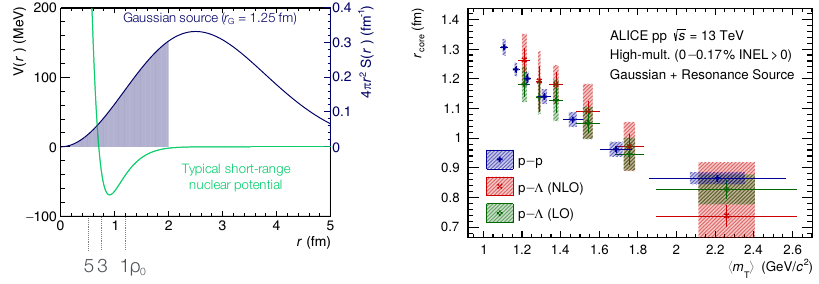
Figure 2. Left: the Gaussian source distribution (blue) for a source size of r G = 1 . 25 fm as a function of the relative distance, compatible with measurements in pp and p–Pb collisions at LHC. In green, a typical short-range nuclear potential as a function of the relative distance. The blue shaded area represents the amount of particle pairs sensitive to the short-range interaction that can be emitted for the given source. Right: Figure taken from [14]. Source radius r core , for p–p (blue) and p– Λ pairs (red [15], green [16]) as a function of average m T using a core Gaussian source with strong resonances